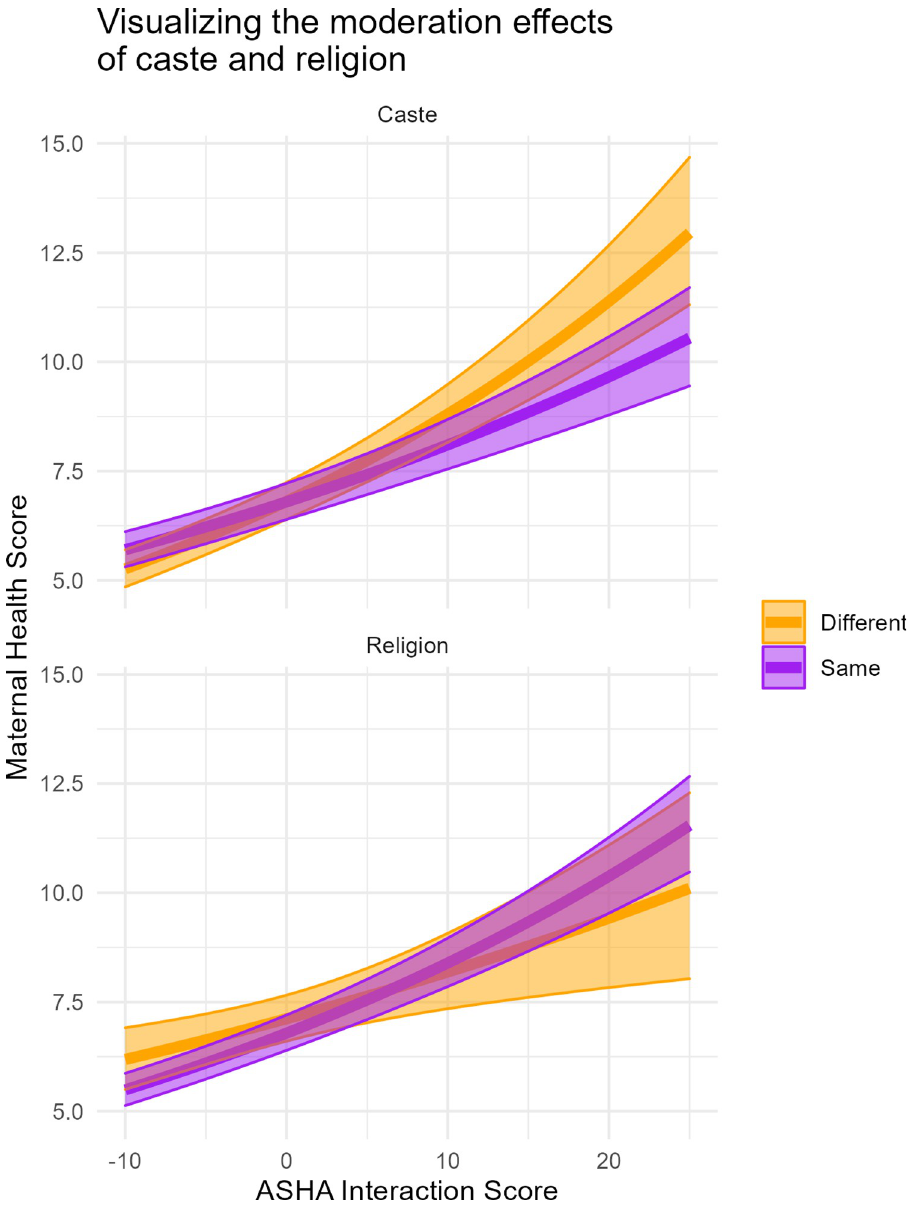
Fig 7. Visualizing the moderating effects of caste and religion on the relationship between ASHA interaction score (mean-centered) and maternal health score.